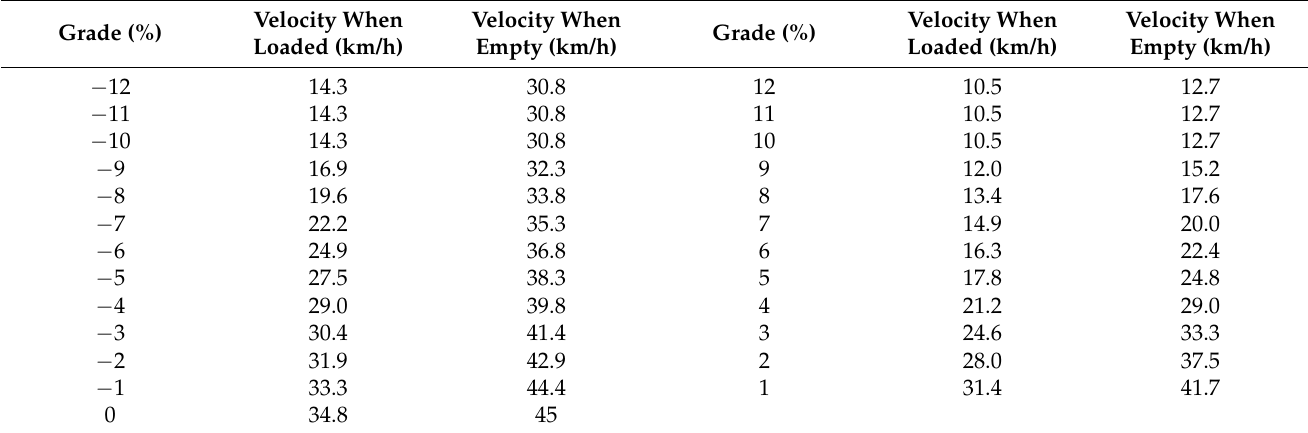
Table 4. Velocities reached by trucks according to road grade.